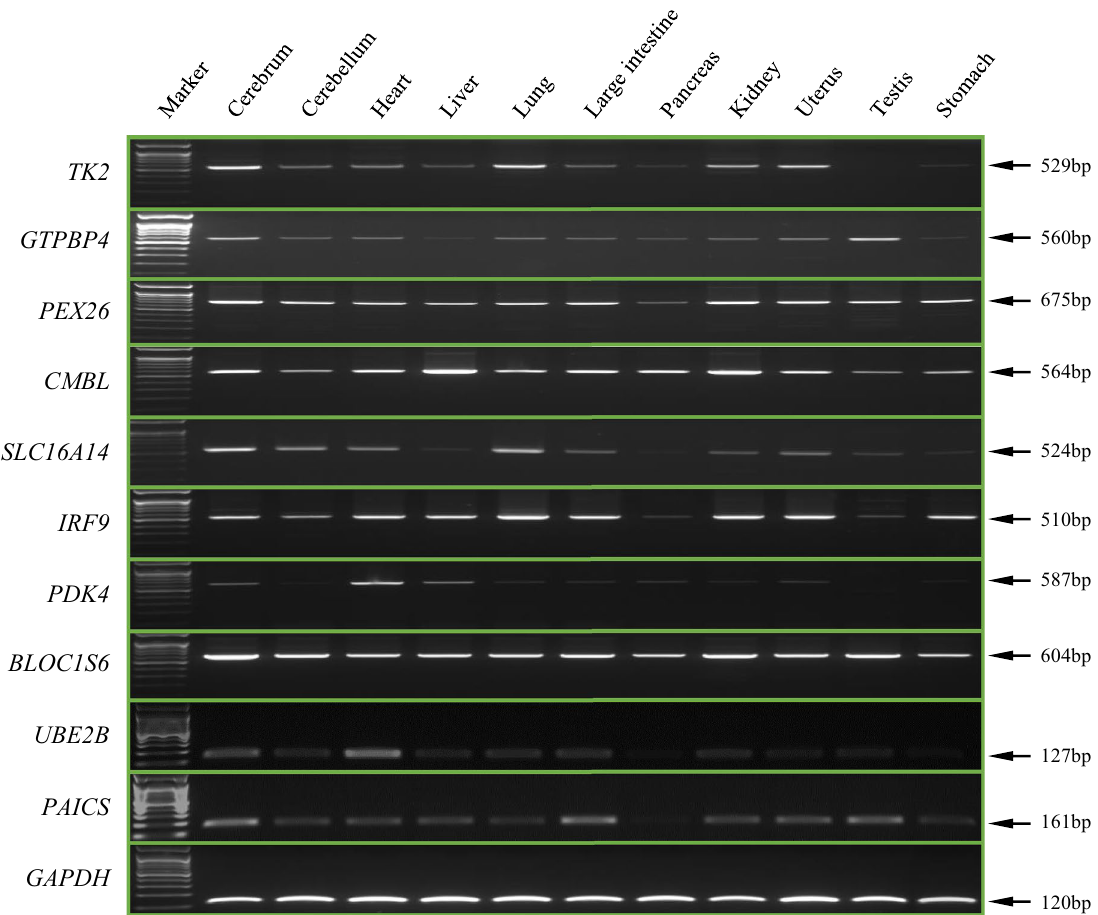
Figure 4. RT-PCR amplification for expression pattern analysis of 10 genes in the crab-eating monkey. TK2 (529 bp), GTPBP4 (560 bp), PEX26 (675 bp), CMBL (564 bp) , SLC16A14 (524 bp), IRF9 (510 bp), PDK4 (587 bp), BLOC1S6 (604 bp), UBE2B (127 bp), PAICS (161 bp) were amplified with a transcript-specific primer set (Supplementary Table S3 and Supplementary Fig. S2). GAPDH (120 bp) indicates positive control. Full- length gels are presented in Supplementary Fig.